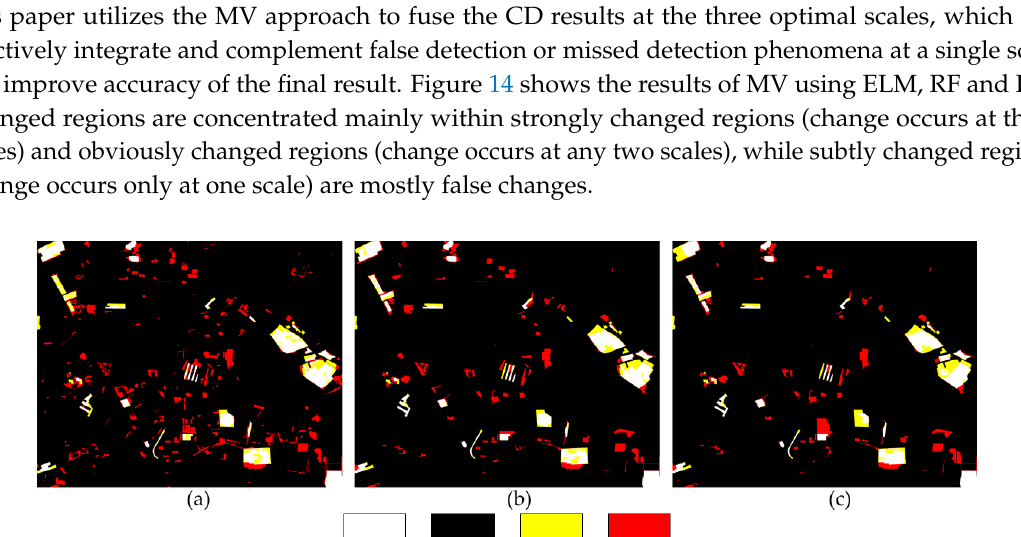
Figure 13. CD results of DS1. ( a ) RoF (Scale 102); ( b ) RoF (Scale 179); ( c ) RoF (Scale 213).